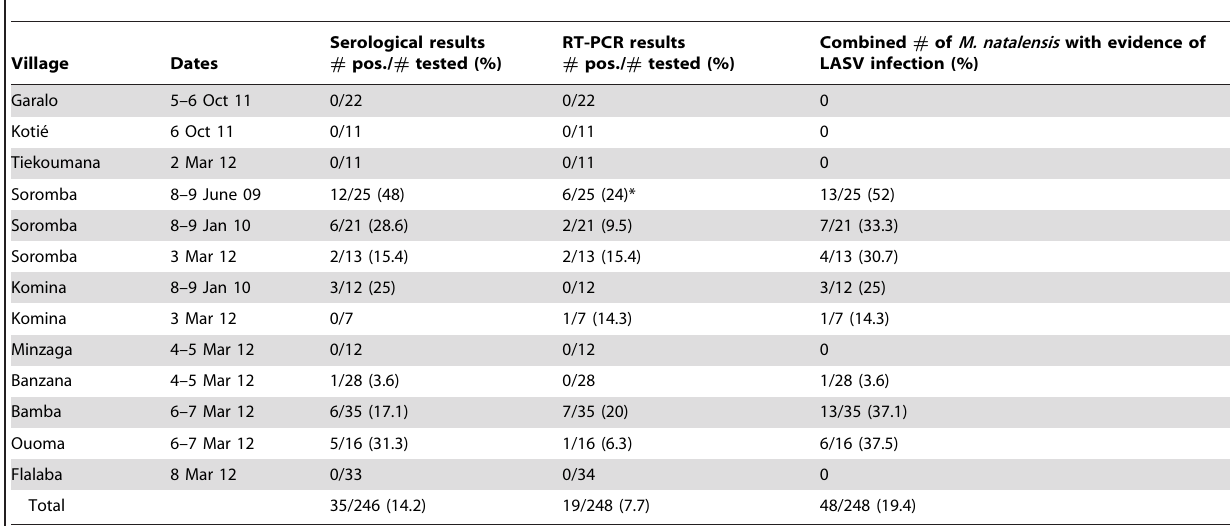
Table 2. Summary of serological and molecular testing for Lassa virus conducted on Mastomys natalensis captured in southern Mali.